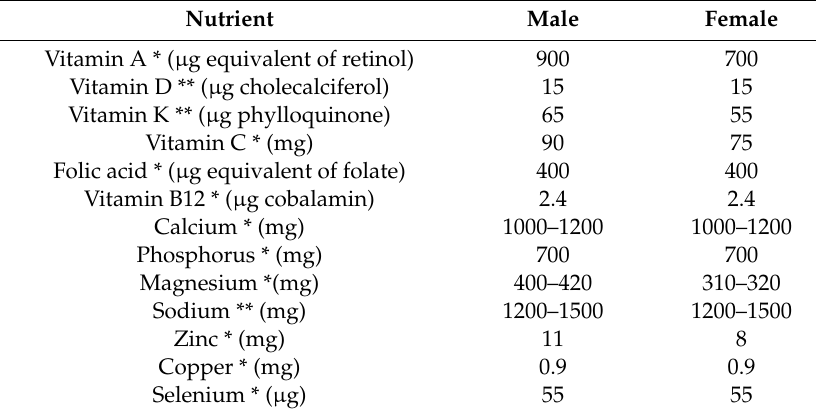
Table 2. Requirements for the selected vitamins and minerals in adults